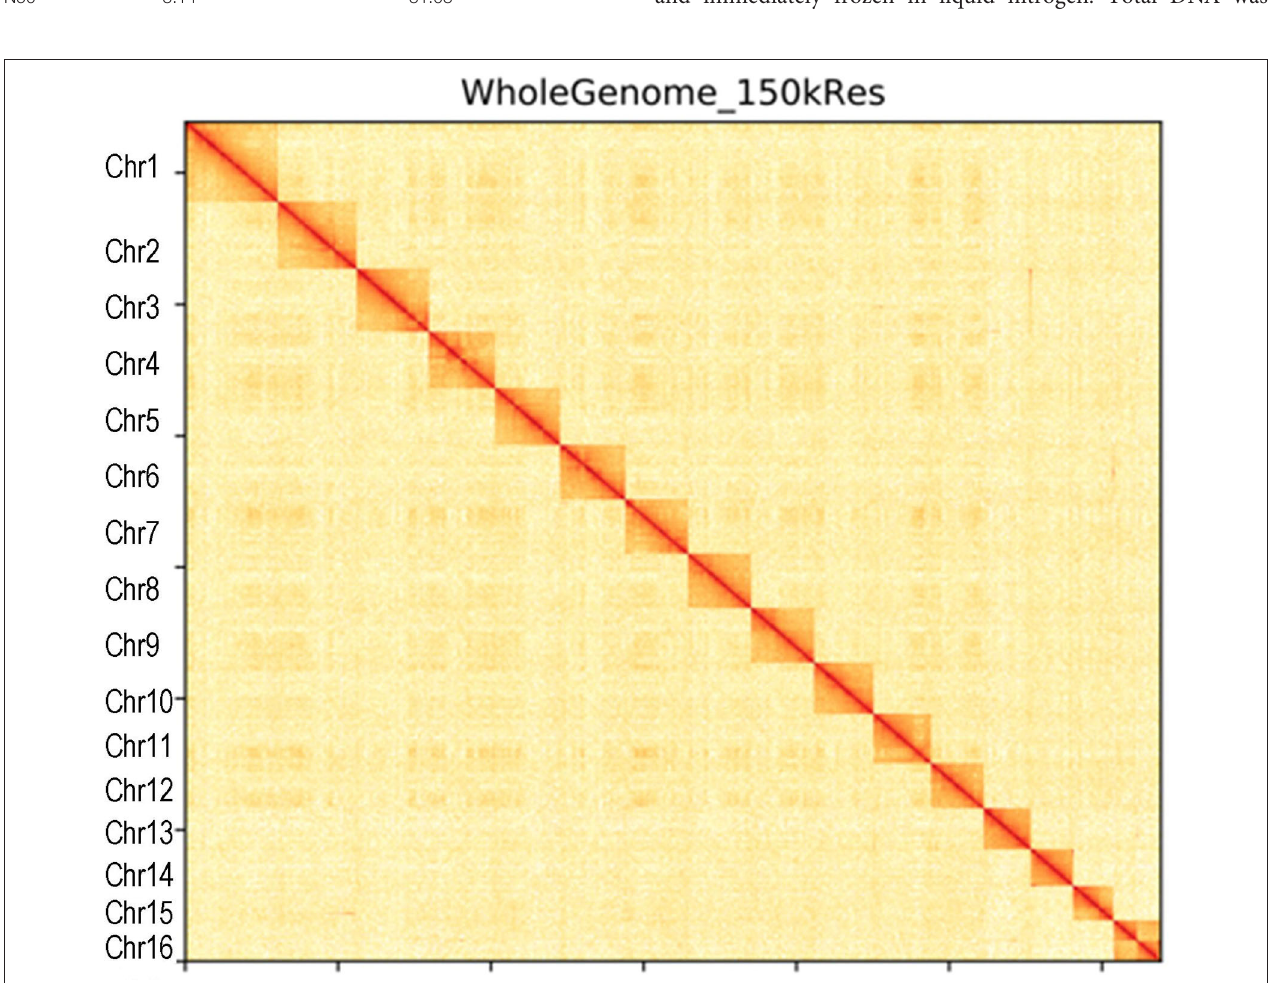
FIGURE 1 | Hi-C interaction heatmap of Capitulum mitella genome. The heatmap shows that the genome was split into 100-kb bins, and the interaction links of individual chromosomes were